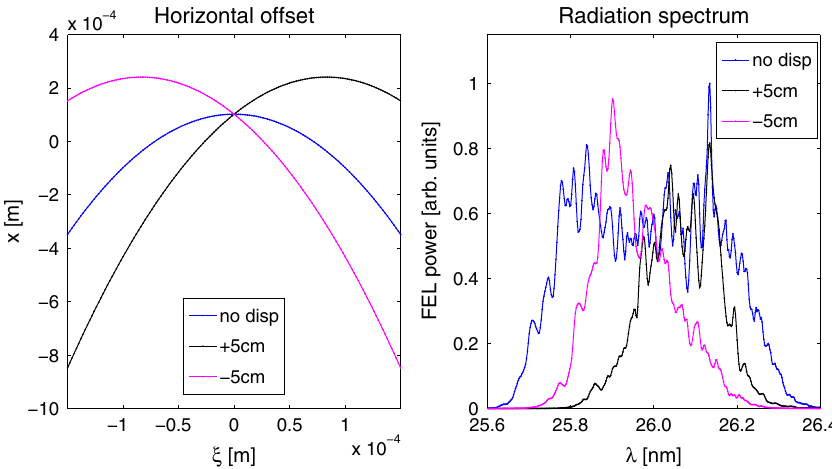
FIG. 14. (Color) Dispersion effects on the wavelength spectrum for an initial quadratic x -energy correlation.